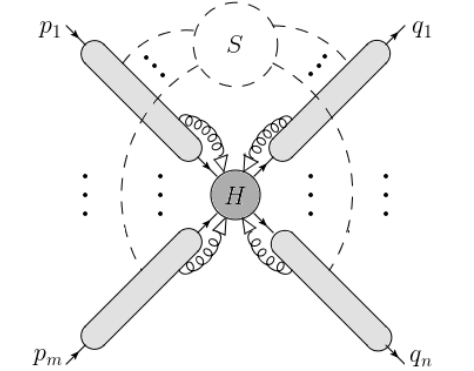
Figure 26. The leading pinch surface of the m ! n wide-angle